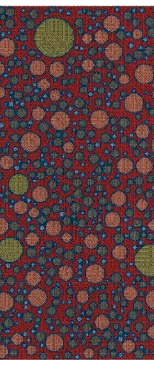
Figure 6. 2D RCA model after meshing.